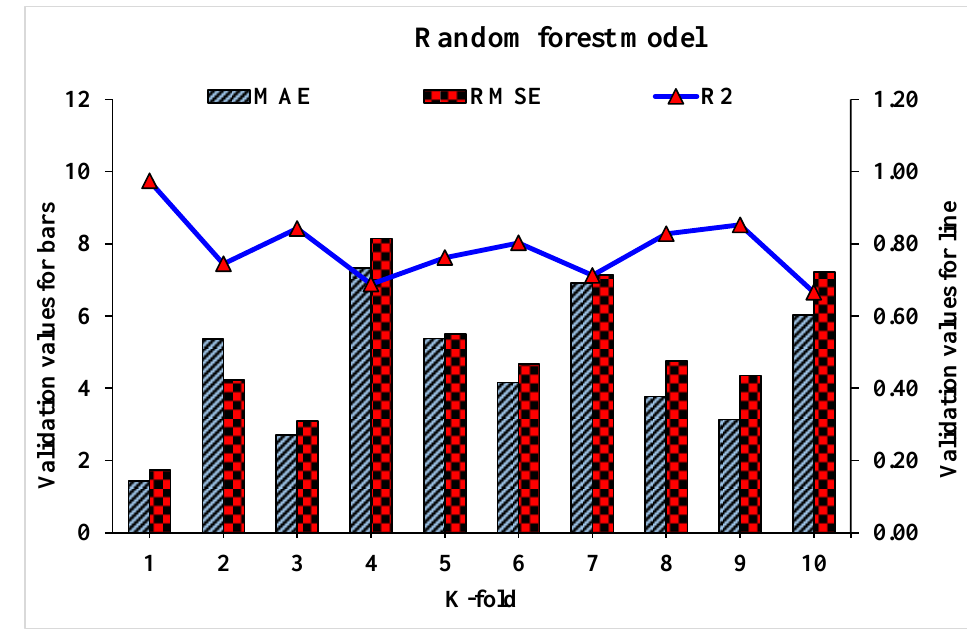
Figure 19. Statistical analysis of RF model for K-fold cross-validation.